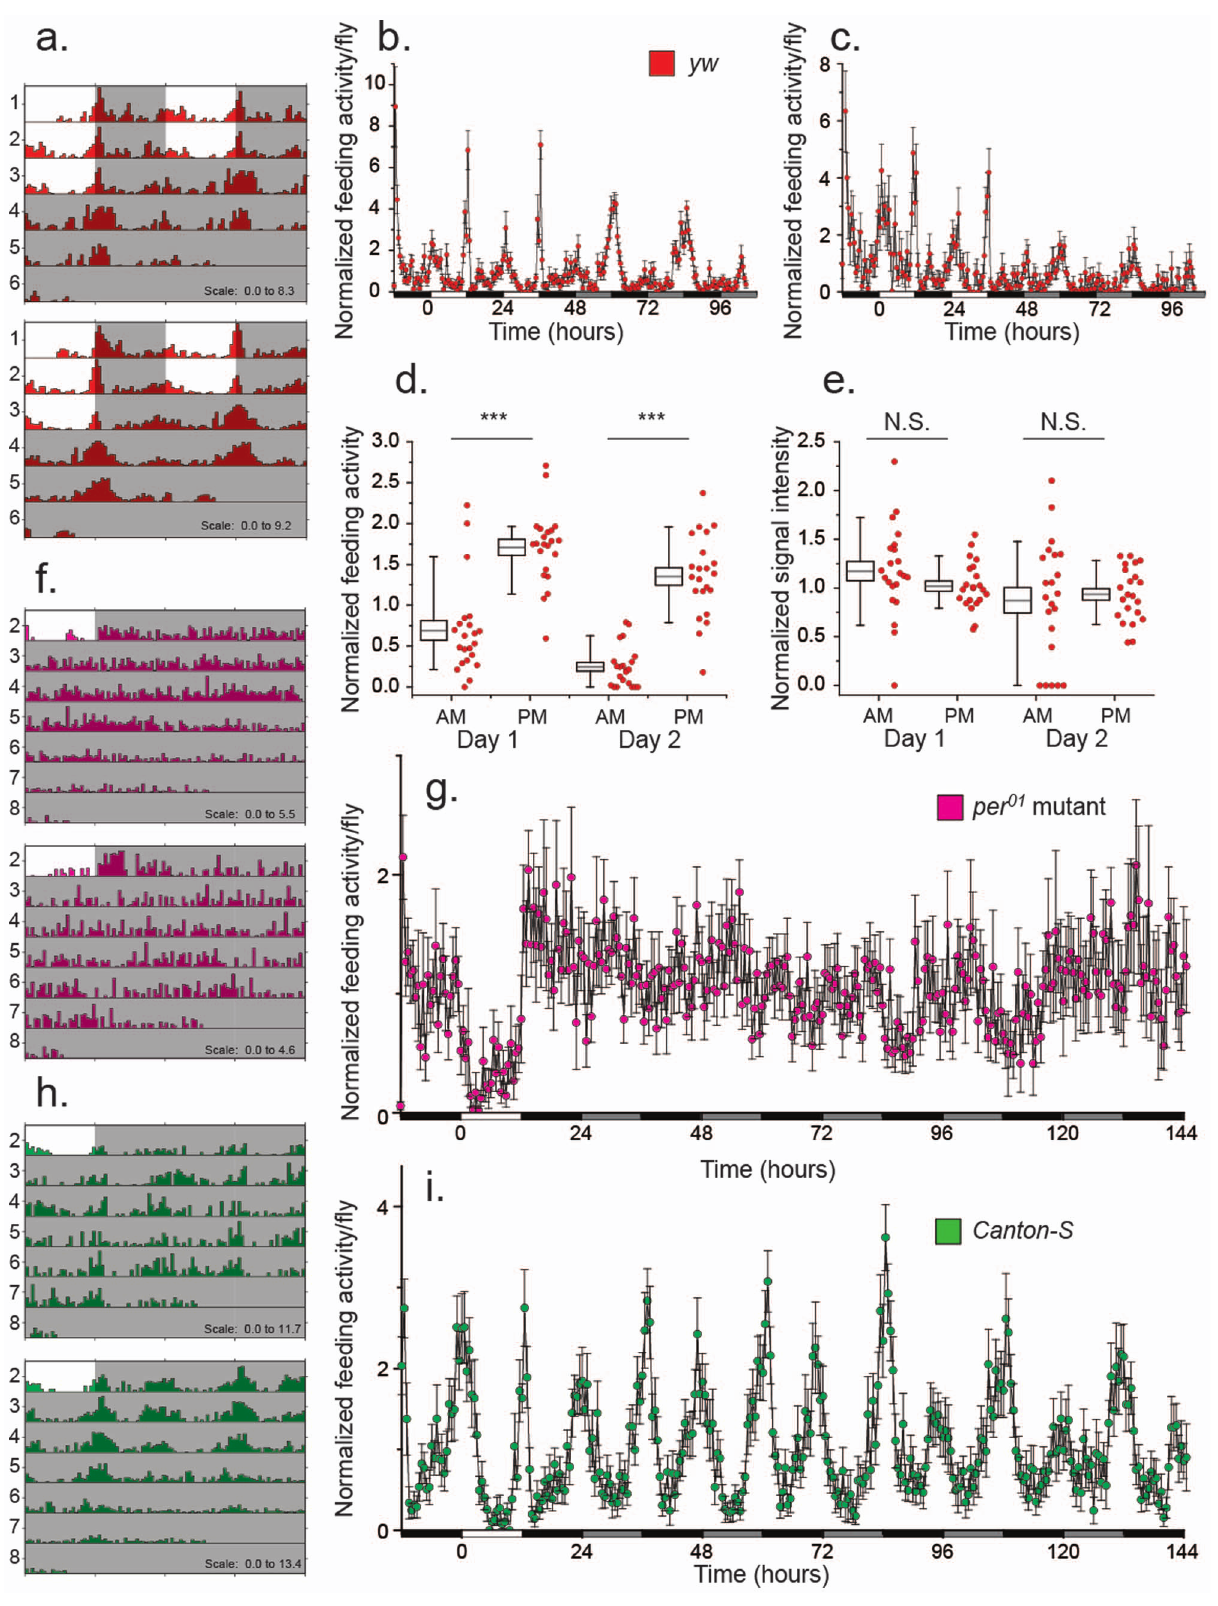
Figure 4. Feeding activity is circadian and dependent on the central pacemaker . (A) Representative actograms for two individual male yw flies depicting circadian feeding behavior during 12 h light: 12 h dark (LD) and constant darkness (DD) conditions. In all actograms, dark background indicates lights-off condition, and white background indicates lights-on conditions. Each horizontal line contains 48 hours of feeding activity data